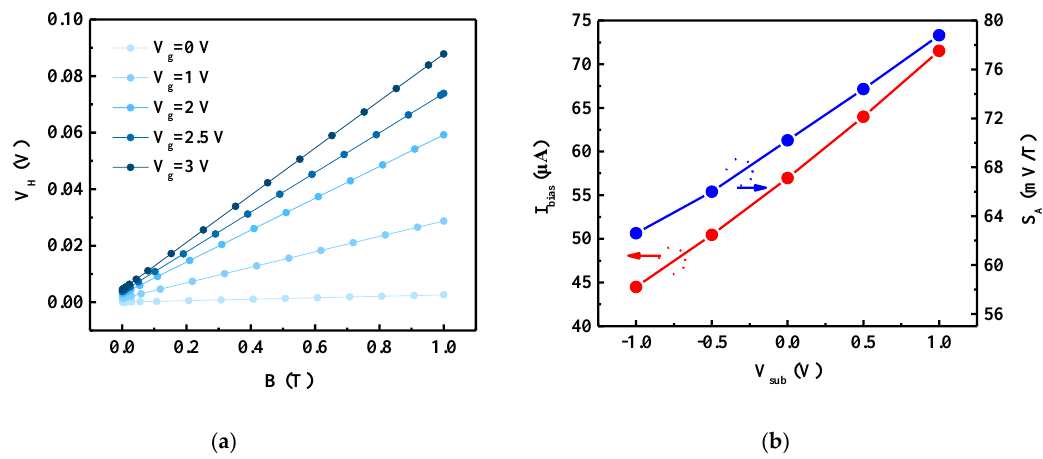
Figure 8. ( a ) Hall voltage ( V H ) versus magnetic induction ( B ) simulated for sensors with different gate voltages ( V g ); ( b ) Bias current ( I bias ) and absolute sensitivity ( S A ) versus substrate voltage ( V sub ).